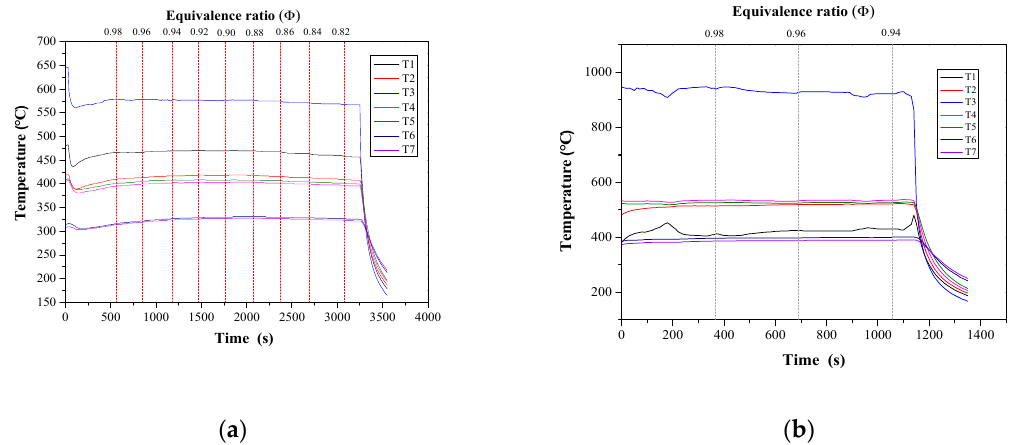
Figure 6. The temperature variation curve over time: ( a ) v = 0.4 m/s (the flame was located at the tube inlet of the tube); ( b ) v = 0.5 m/s (the flame was located at the front of the catalyst).